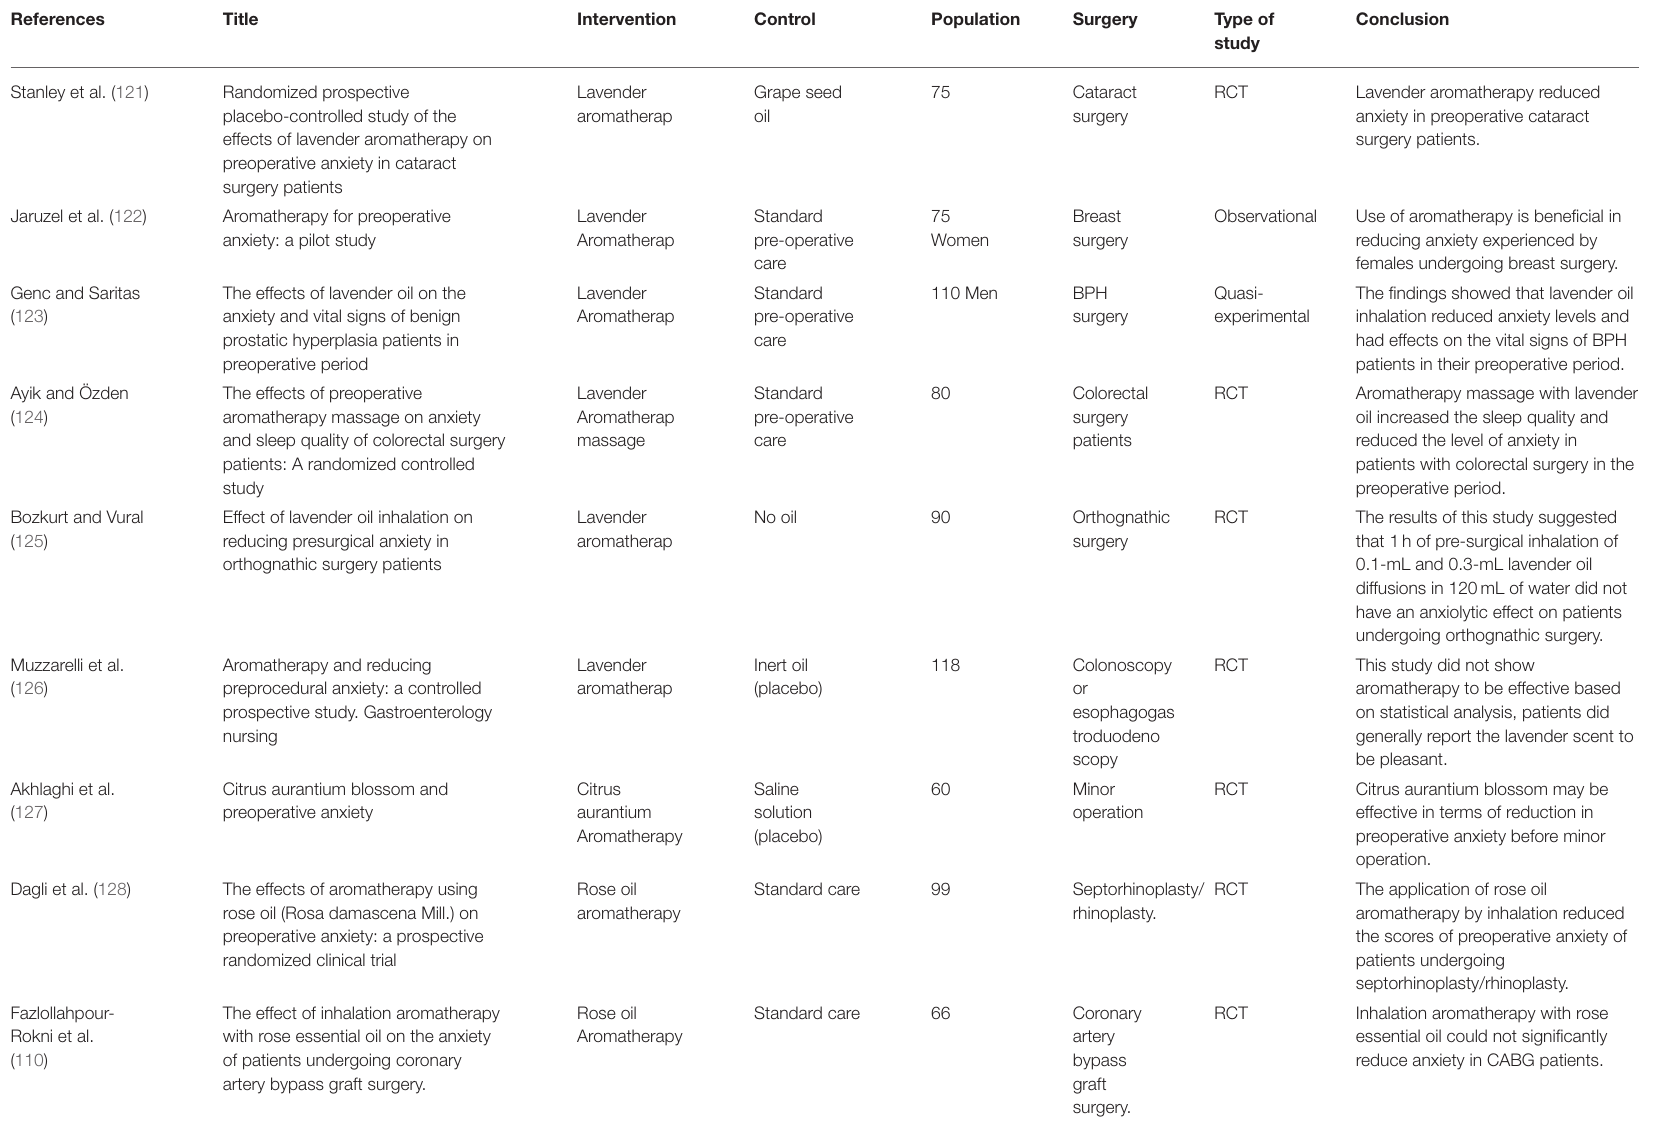
TABLE 3 | Clinical studies on the efficacy of aromatherapy and massage in preoperative